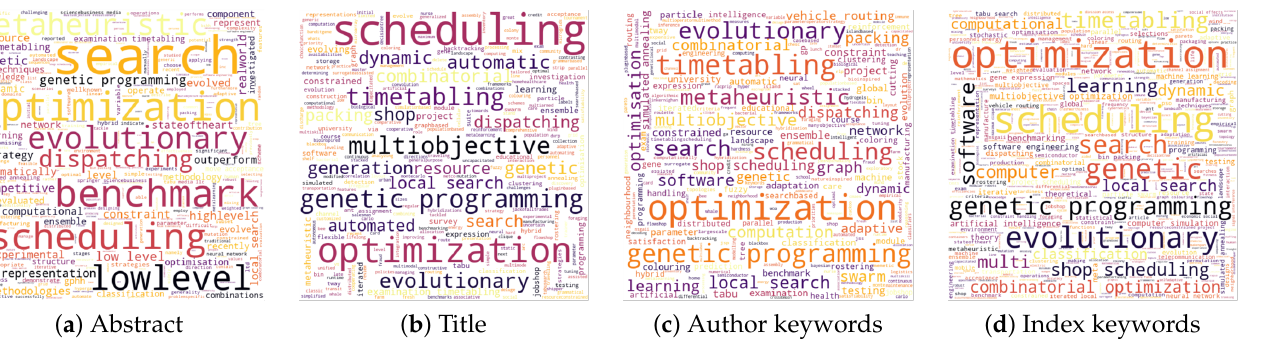
Figure 4. Word clouds for elements of interest in the